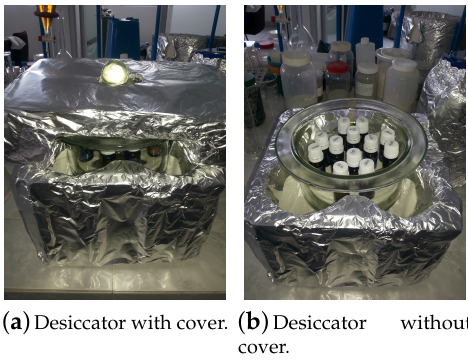
Figure A11. Desiccator with cover to reduce the exchange of temperature with the outside.